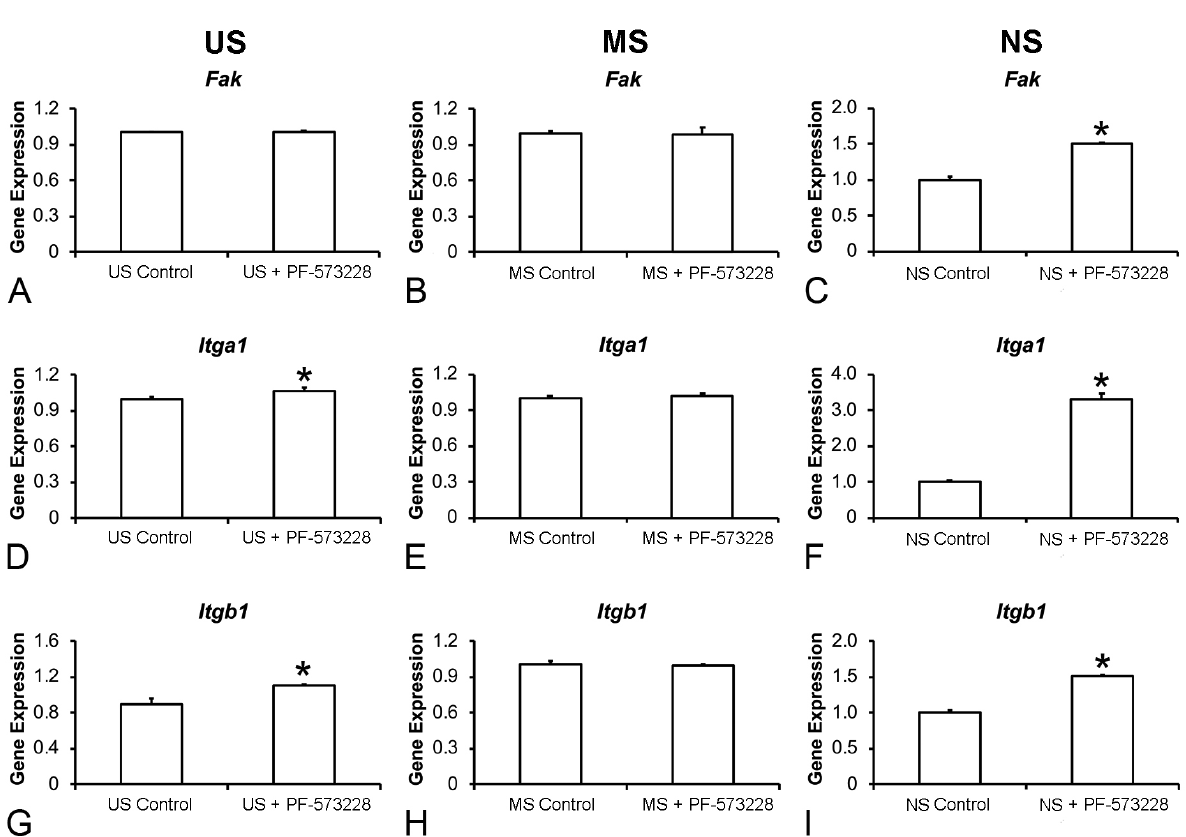
Figure 7- Gene expression of the integrin signaling pathway components focal adhesion kinase (Fak, A), integrin a 1 (Itga1, B), and integrin b 1 (Itgb1, C) in cells cultured on US, MS, and NS in presence or absence of 0.1 µM PF-573228 on day 10. The data are presented as mean ± standard deviation (n=3), and asterisks (*) indicate statistically significant differences